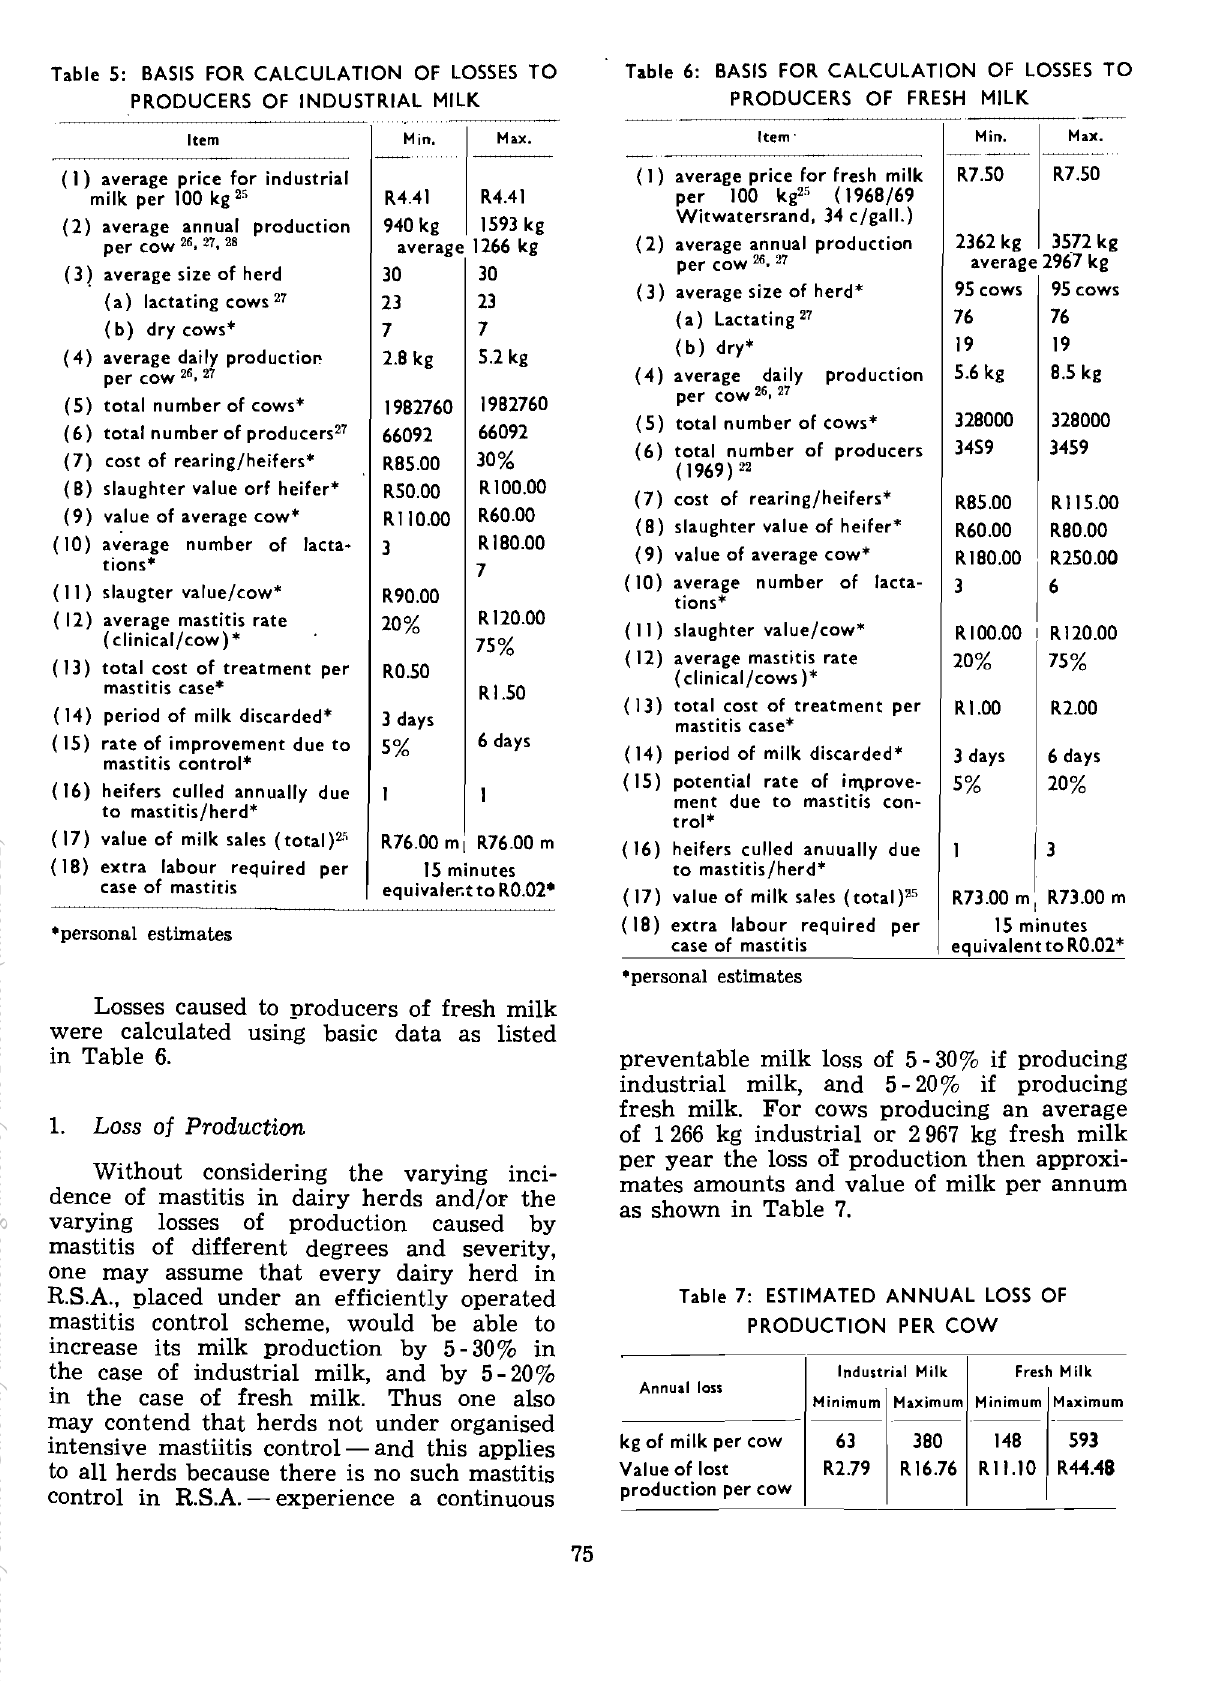
Table 6: BASIS FOR CALCULATION OF LOSSES TO